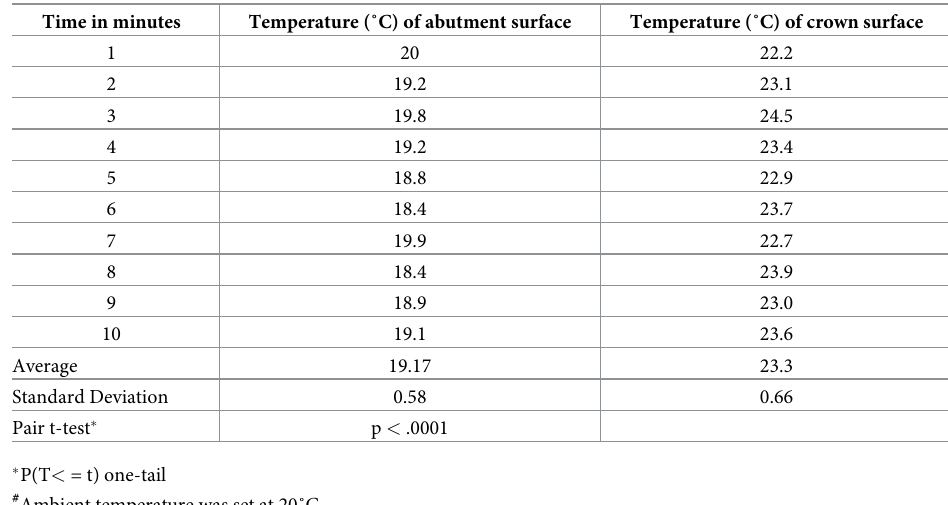
Table 2. Temperature measurements during irradiation for decementation with Er:YAG laser of the all-ceramic crowns from Zirconia abutments cemented with resin cement # . Time in minutes